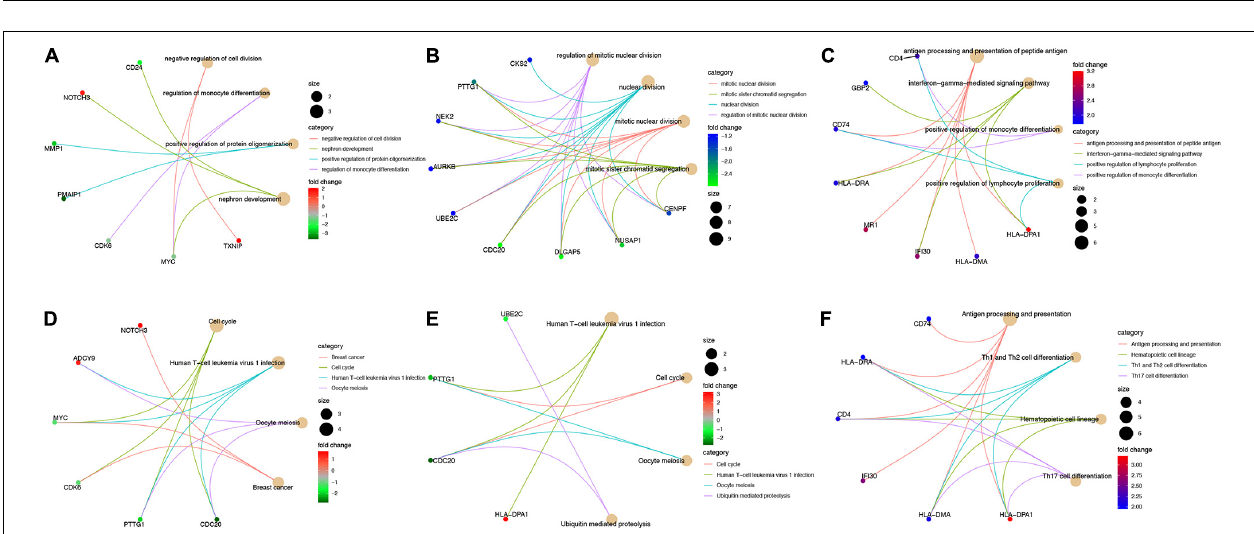
FIGURE 7 | Sub-networks (A–C) and correlation matrixes (D–F) of hub genes and their first neighbors: (A,D) MYC ; (B,E) KIF20A ; (C,F) HLA-DRA and HLA-DPA1 .